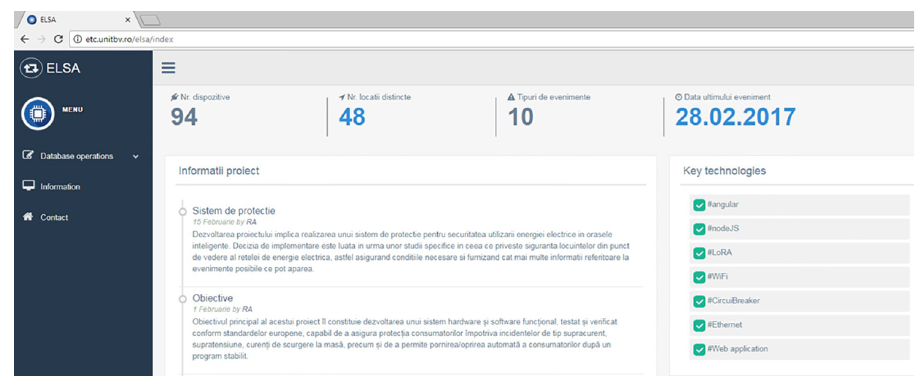
Fig 5. Web interface for remote monitoring of the protection devices—Homepage